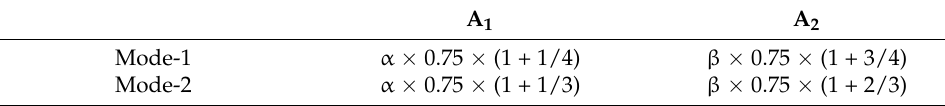
Figure 4. 2-level quantization method. Figure 4. 2 -level quantization method. Table 3. Two modes of 2-level quantization of A-register value. Table 3. Two modes of 2-level quantization of A-register value.